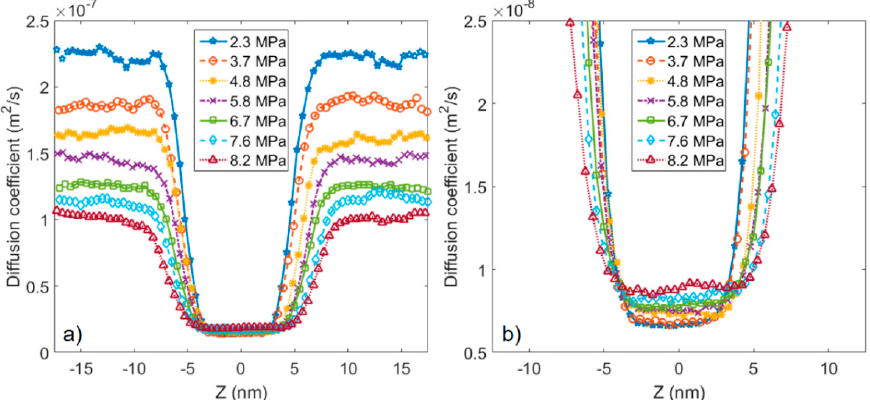
Figure 5. Diffusion coefficient distribution along the Z-direction under different pressures. ( a ) CO 2 , ( b ) n -octane.